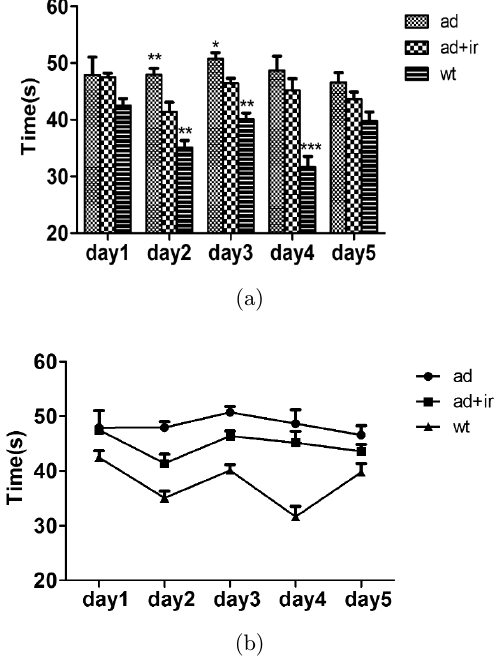
Fig. 1. The results of the ¯rst round MWM task. (a) The column graph of ¯rst round MWM data. (b) The line chart of ¯rst round Morris water data. All data are expressed as means (cid:2) SEM. We compared the means of ad ( n ¼ 8) and wt ( n ¼ 12) with that of ad þ ir ( n ¼ 6) using two-way ANOVA followed by LSD post-hoc ( (cid:5) p < 0.05, (cid:5) (cid:5) p < 0.01, (cid:5) (cid:5) (cid:5) p <